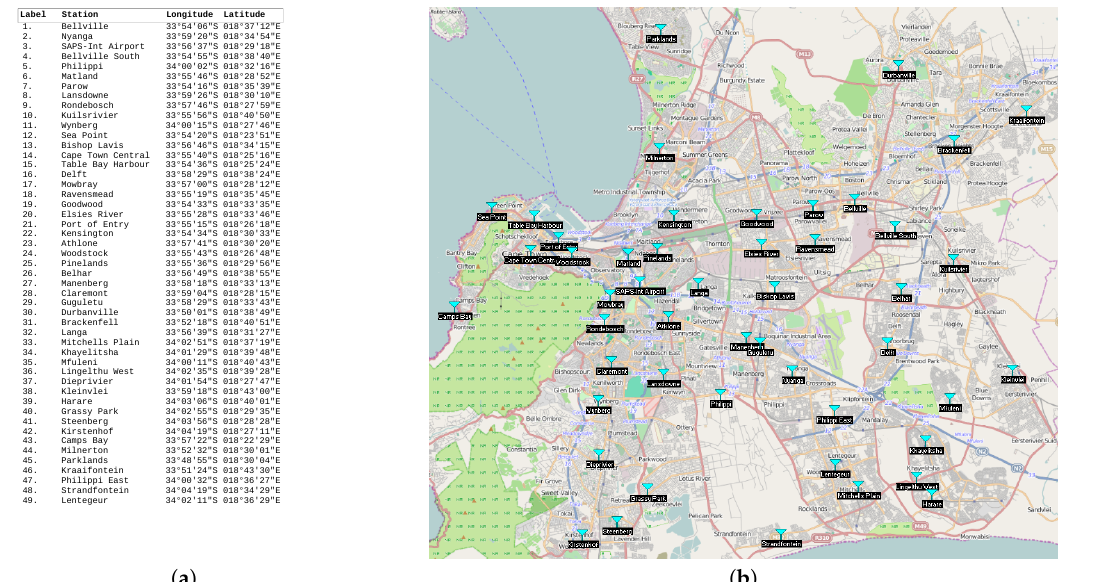
Figure 9. Case study. ( a ) GPS positions; ( b ) positions on the